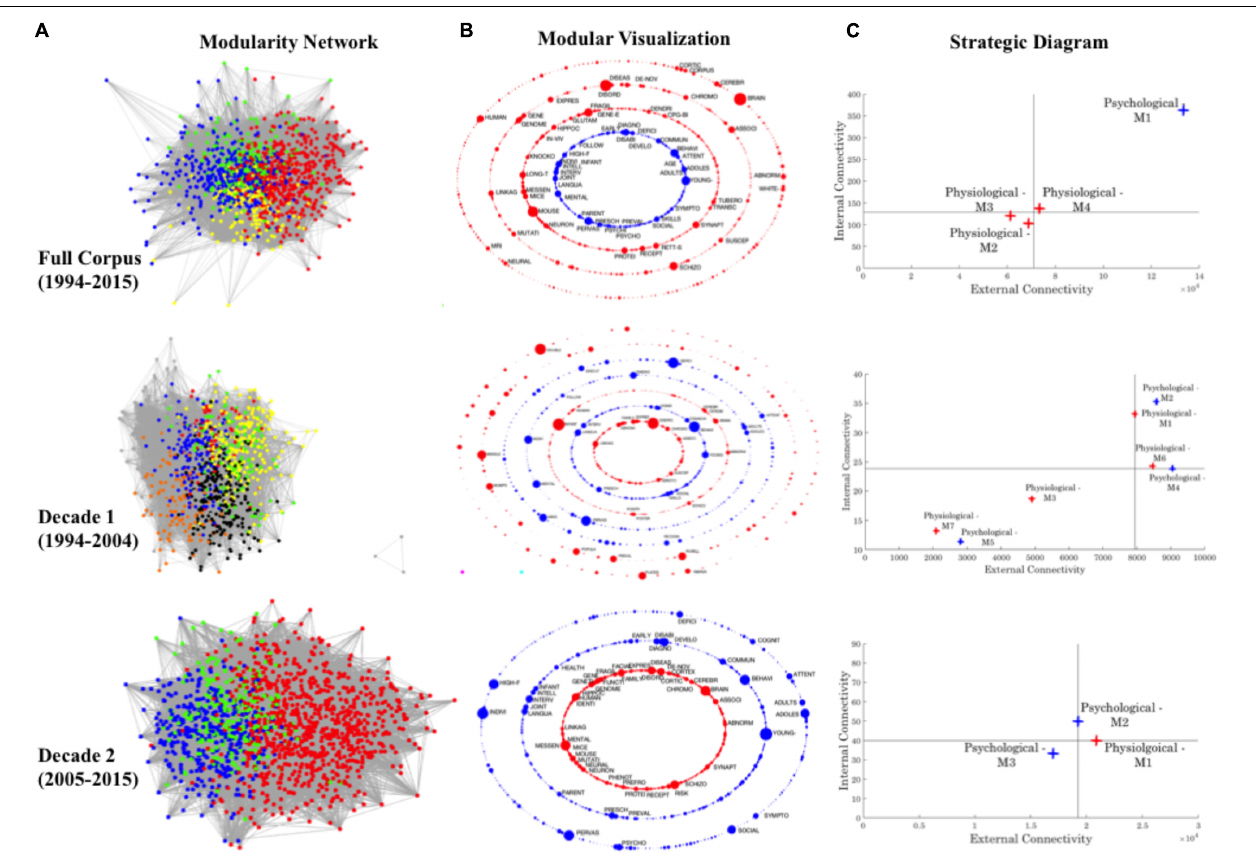
FIGURE 5 | (A) Refinement of the network after the removal of core network hubs to assess the stability of network clusters and modularity at all levels of examination. As demonstrated in (B) , these are classified into Psychological, or Physiological focus based upon core internal nodes. This categorization is color coded ( Psychological: Blue; Physiological: Red, Green: Interdisciplinary ), with the order of concentric rings reflecting each module’s rank. In addition, this corpus was systematically deconstructed to consider patterns across two individual decades (Decade 1: 1994–2004 and Decade 2: 2005–2015), and internal and external connectivity metrics (C) . Intuitively, the removal of network hubs leads to reduced levels of overarching median normalized external and internal connectivity at all levels. See Supplementary Table 4 for comparisons. For larger high resolution figures please see